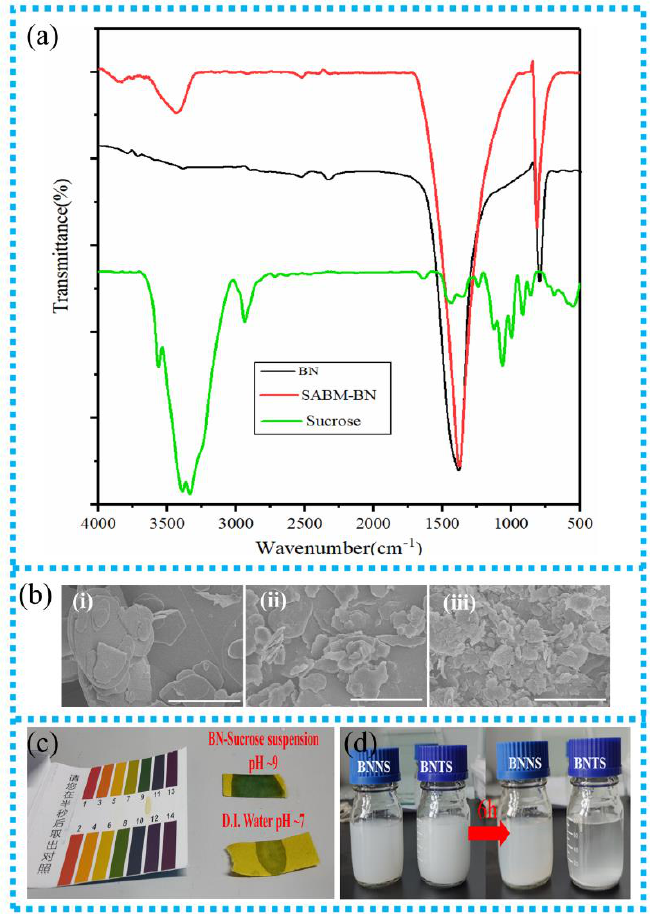
Figure 2. ( a ) FT-IR spectra of BN, sucrose, and SABM-BN. ( b ) SEM images of (i) BN, (ii) BNTS, and (iii) BNNS, respectively (scale bar: 10 μm) . ( c ) Detection pH of BN-Sucrose suspension and D.I. water. ( d ) Stability of BNNS and BNTS (~1 mg/mL) aqueous solution for 6 h.